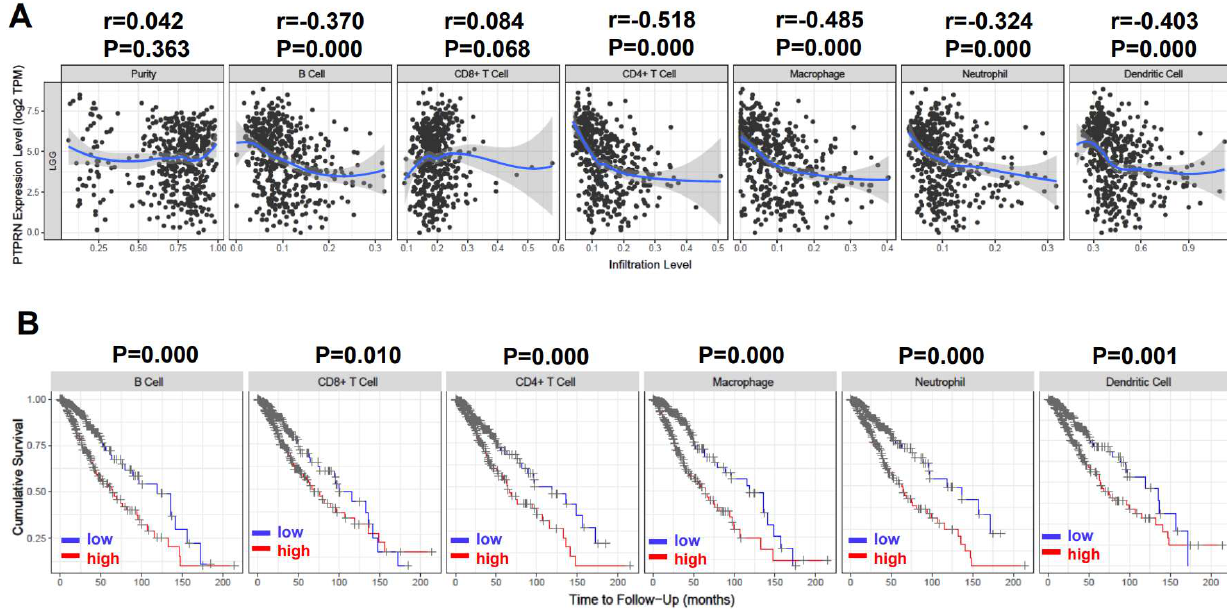
Figure 4 . Correlation of PTPRN expression with immune infiltration level in LGG. ( A ) PTPRN ex- pression level has significant negative correlations with infiltrating levels of B cell ( r = −0.370, p = 0.000), CD4+ T cells ( r = −0.518, p = 0.000), Macrophages ( r = −0.485, p = 0.000), Neutrophils ( r = −0.324, p = 0.000) and DCs ( r = −0.403, p = 0.001) in LGG. ( B ) Cumulative survival is related to B cell ( p = 0.000), CD8+ T cells ( p = 0.010), CD4+ T cells ( p = 0.000), Macrophages ( p = 0.000), Neutrophils ( p = 0.000) and DCs ( p = 0.001) in LGG.